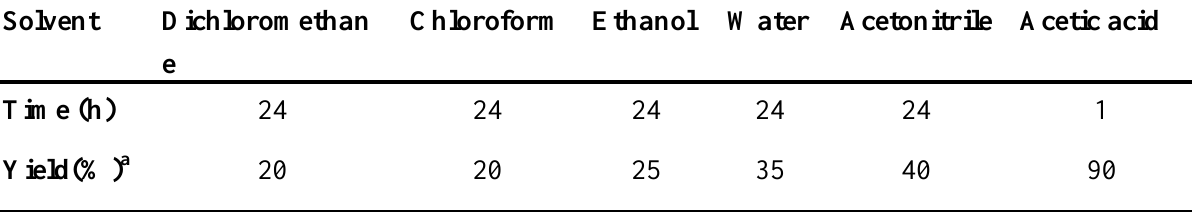
Table 1. The effect of the solvent on the oxidation of